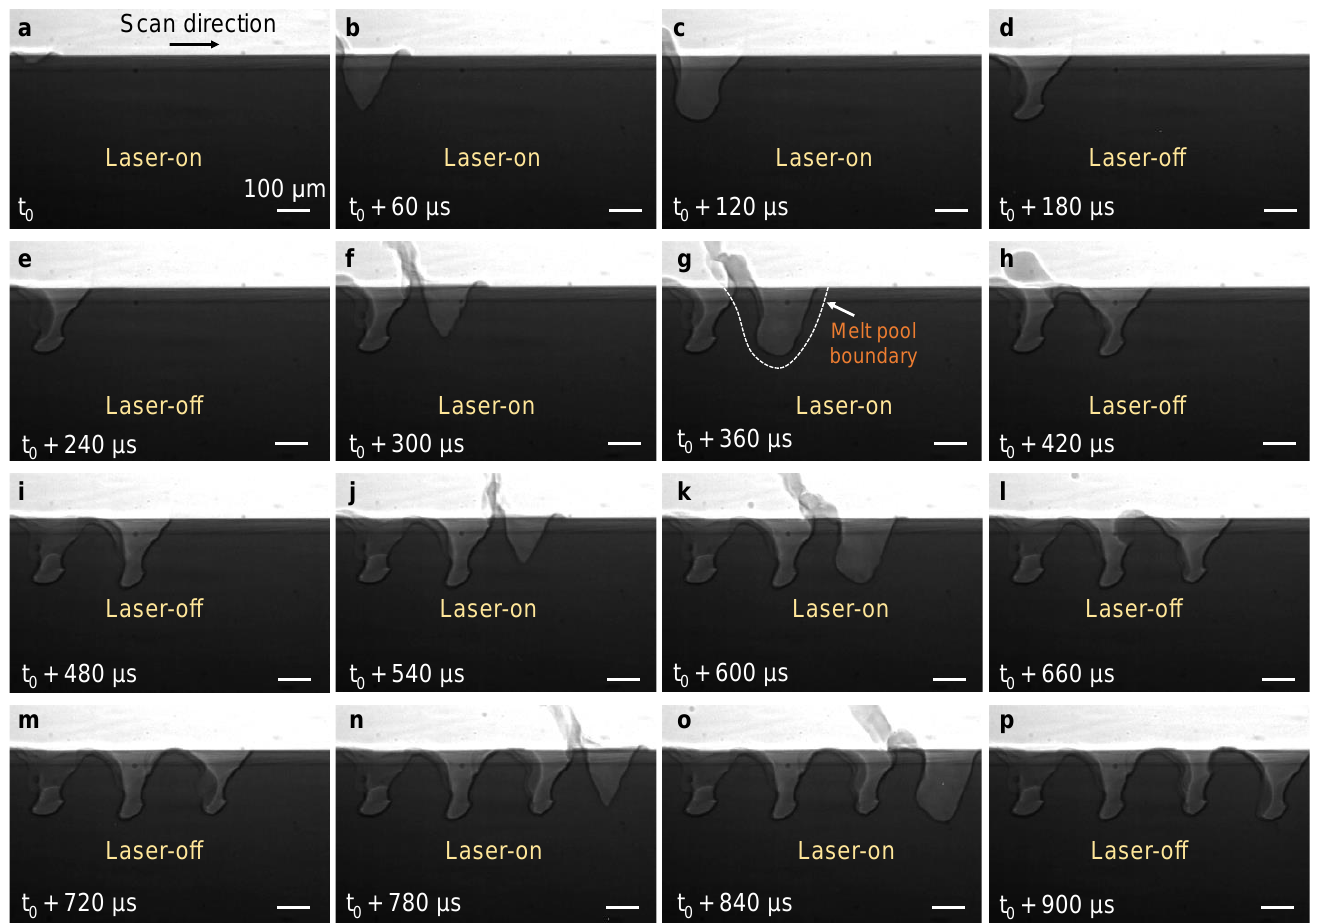
Figure 4. Cavity pattern formation at low laser frequency: ( a – p ) Dynamic X-ray images showing formation of cavity during pulsed-wave laser melting of Ti-6Al-4V substrate at a laser frequency of 4 kHz, a duty cycle of 50%, a laser power of 420 W, and a scan speed of 0.8 m/s. Note that some image frames during laser-on time and laser-off time have been skipped. The compiled movie showing the details is available in the Supplementary Material (Movie S7).